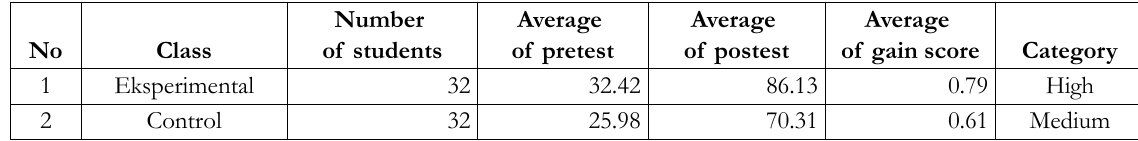
Table 12. Result of improvement in mathematical representation